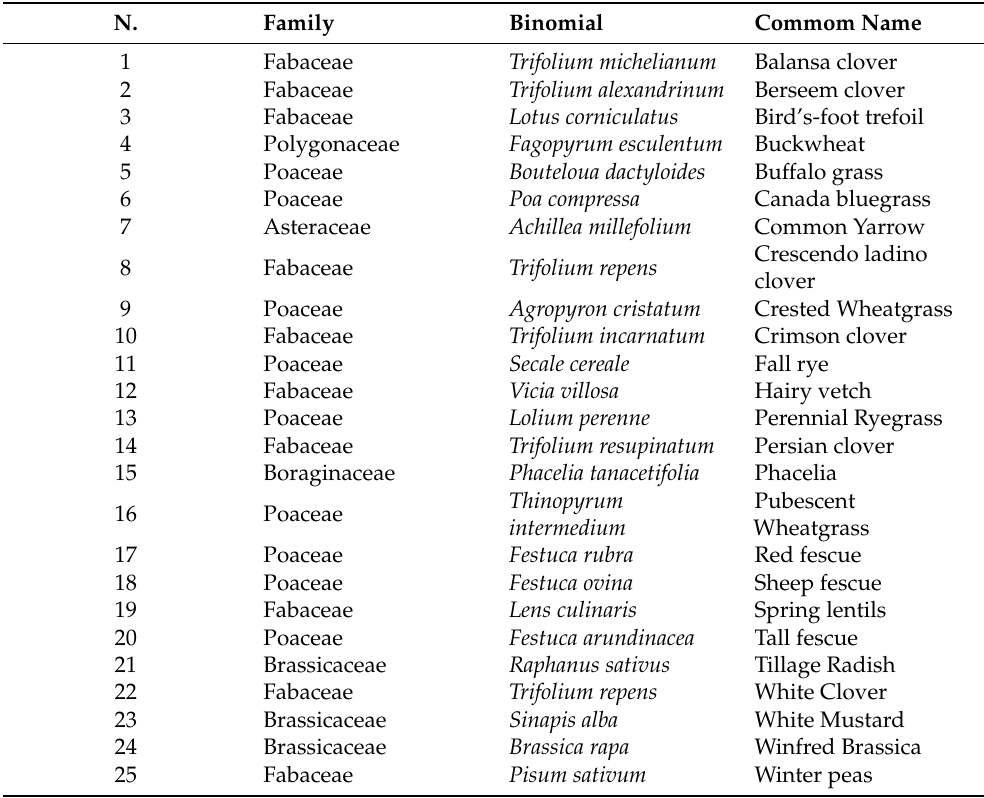
Table 1. List of vineyard cover crops that were inoculated with Ilyonectria liriodendri. N. Family